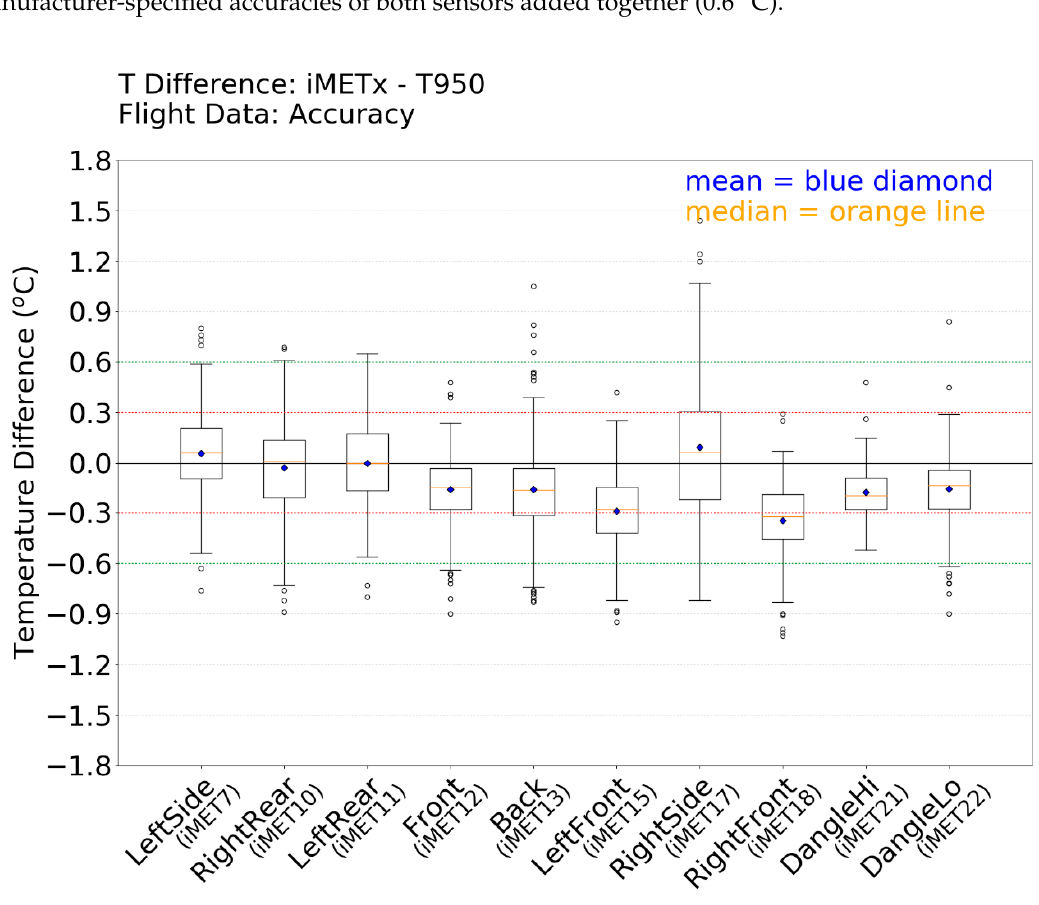
Figure 5. Temperature difference (°C) between each iMET-XQ sensor and the 9.5 m thermistor on the South Alabama Mesonet tower for all flight experiments. The iMET-XQ number and location on the UAV are given on the x axis. The means are represented by blue diamonds, and the medians are shown by orange lines. A temperature difference of 0.3 °C is marked by a red dotted line. A temperature difference of 0.6 °C is marked by a green dotted line.